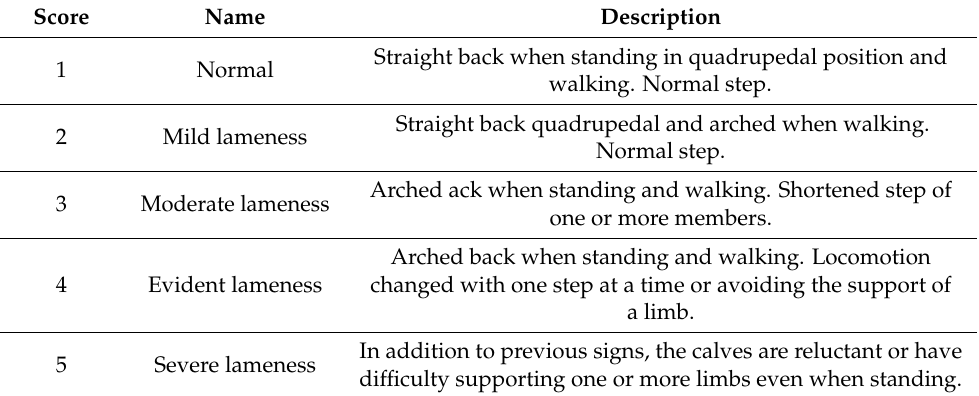
Table 2. Lameness score in cattle